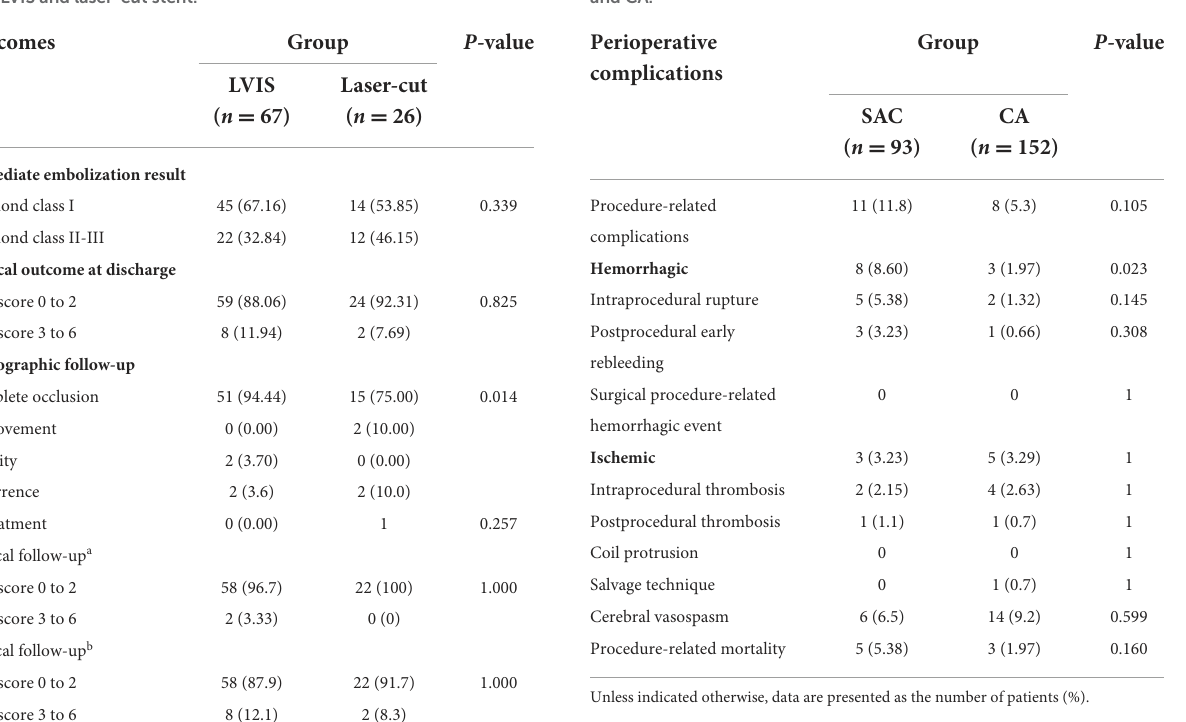
TABLE 4 Perioperative Complications for patients treated with SAC and